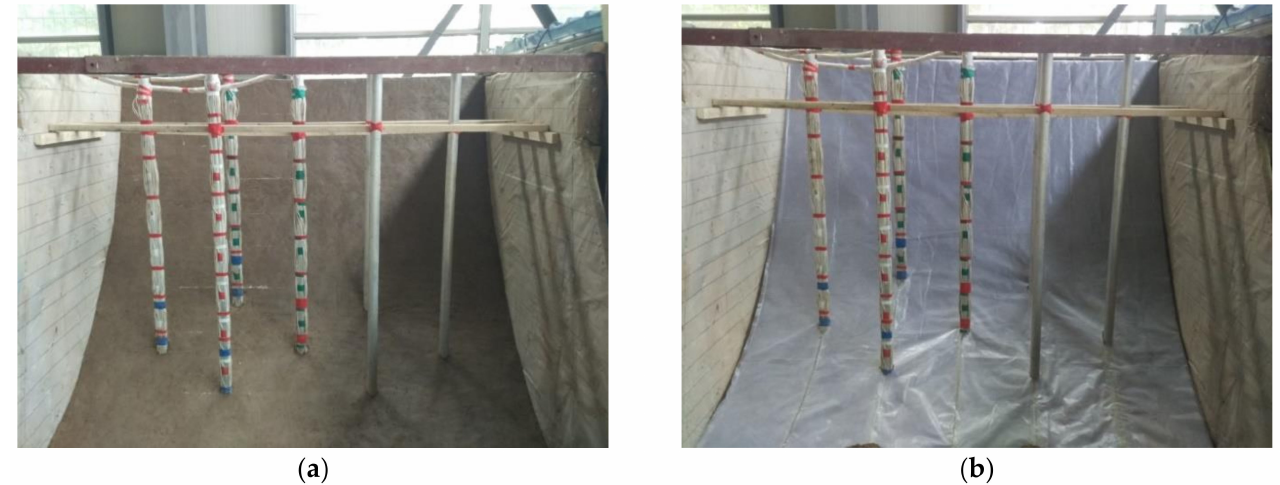
Figure 3. Schematic diagram of sliding surface: ( a ) the sliding surface; ( b ) double-layer plastic films were put on the sliding surface.